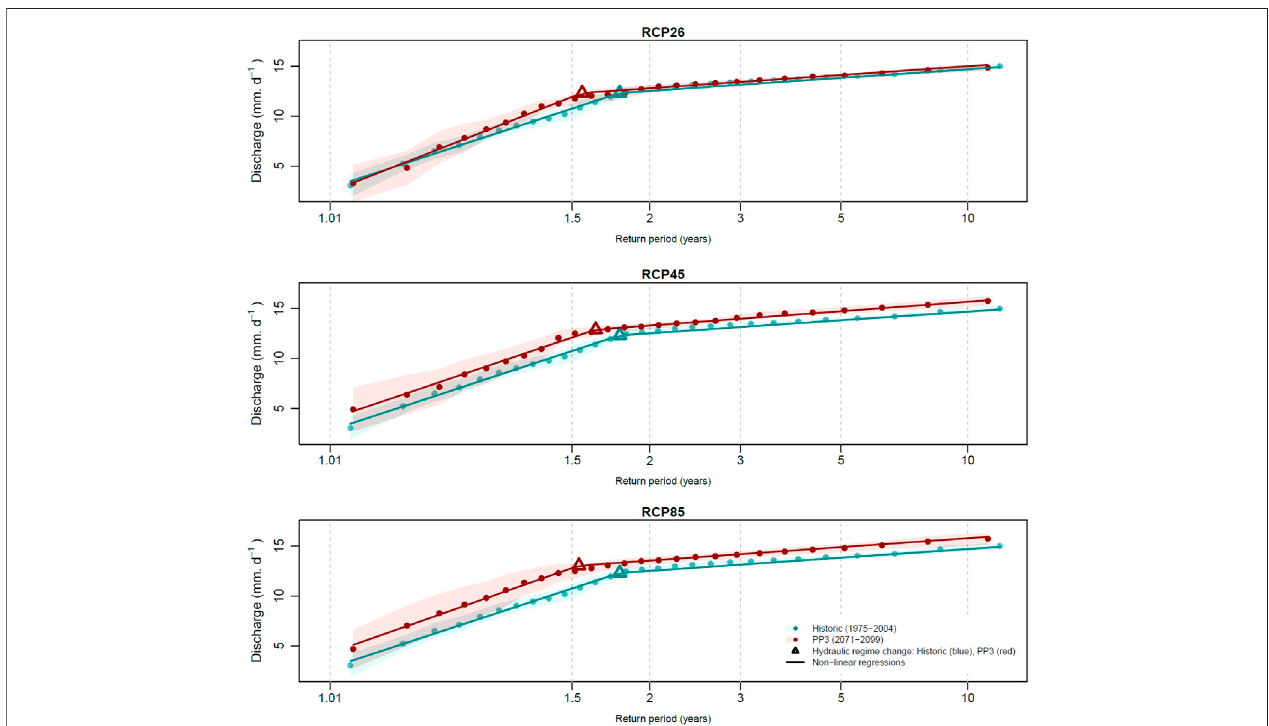
FIGURE 6 | Comparison of the speci fi c discharges Q spe (here Q max ) associated with return periods RPs between the projected future period 2071 – 2099 (red points) and the projected historical period 1975 – 2004 (blue points), for the three RCPs. Each scatter plot was calculated from the mean of the distribution functions of Q max from the available CPs according to the corresponding RCP ( Table 1 ), supported by a con fi dence interval at 95%. The equation Q spe (cid:2) f ( RP ) was fi tted as a piecewise function (see Eq. 8 ) by non-linear regression, for all cases.